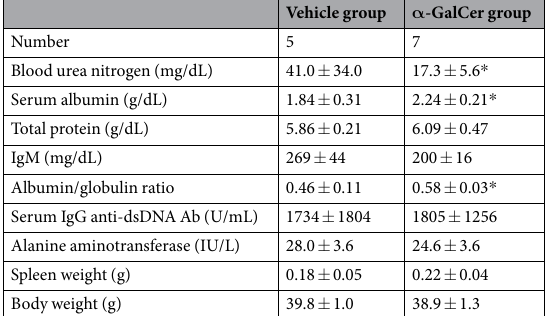
Table 1. Biochemical and physiological parameters at the end of the experiment. Data are presented as mean ± SEM or number. * p < 0.05 (Student’s t -test). α -GalCer: alpha-galactosylceramide.